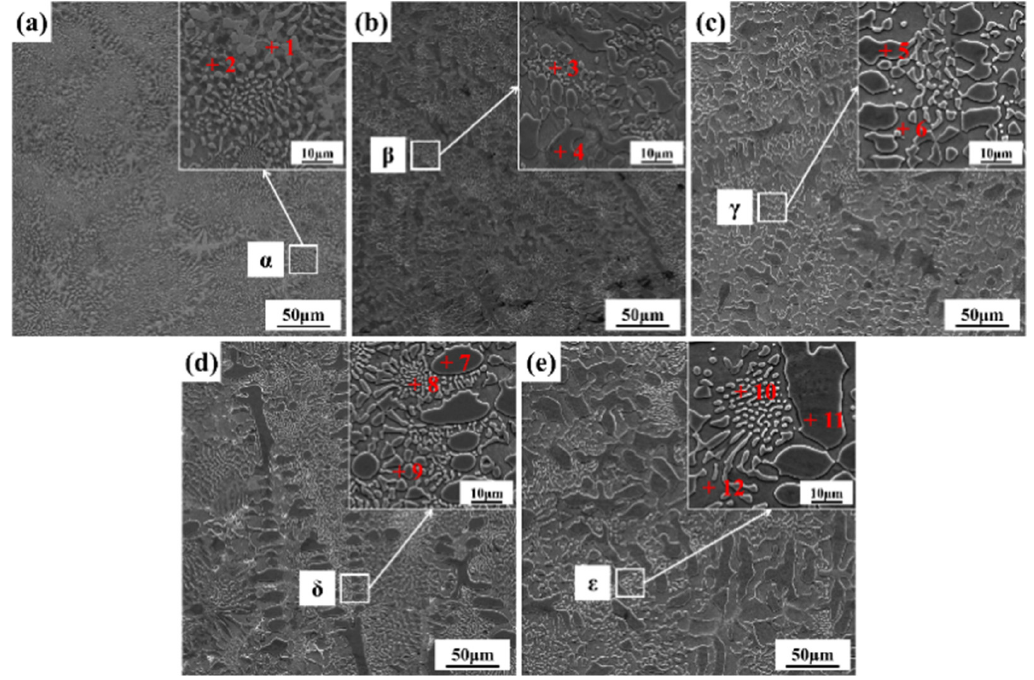
Figure 2. Microstructures of AlSi 0.5 Cr x Co 0.2 Ni high entropy alloys; ( a ) x = 1.0, ( b ) x = 1.2, ( c ) x = 1.4, ( d ) x = 1.6, and ( e ) x =